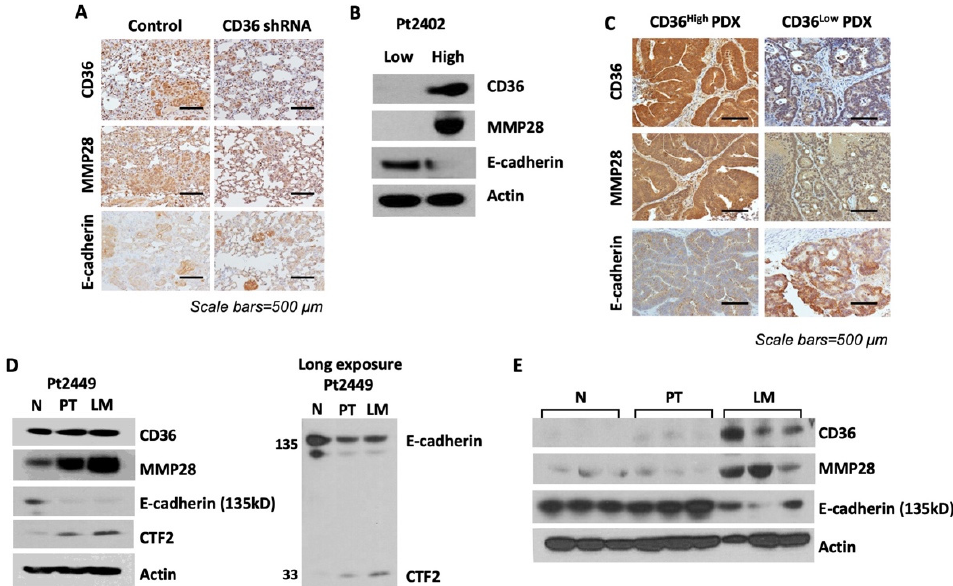
Figure 6. Overexpression of CD36 is associated with an increase in MMP28 expression and reduction in the level of E-cadherin in vivo and human CRC specimens. ( A ) IHC analysis of the tissues from tail-vein injection of the HT29 LuM3 GFP-Luciferase NTC and shCD36 cell lines shown in Figure 3A. ( B ) Western blot analysis and ( C ) IHC analysis of the tissues from Pt2402 PDX, CD36 low and CD36 high, the isogenic tumors for CD36, MM28 and E-cadherin. ( D ) Western blot analysis of matched normal (N), primary tumor (PT) and liver metastasis (LM) tissues for CD36, MMP28, E-cadherin and CTF2. ( E ) Western blot analysis of CD36, MMP28 and E-cadherin in unmatched N, PT and LM patient tissues.